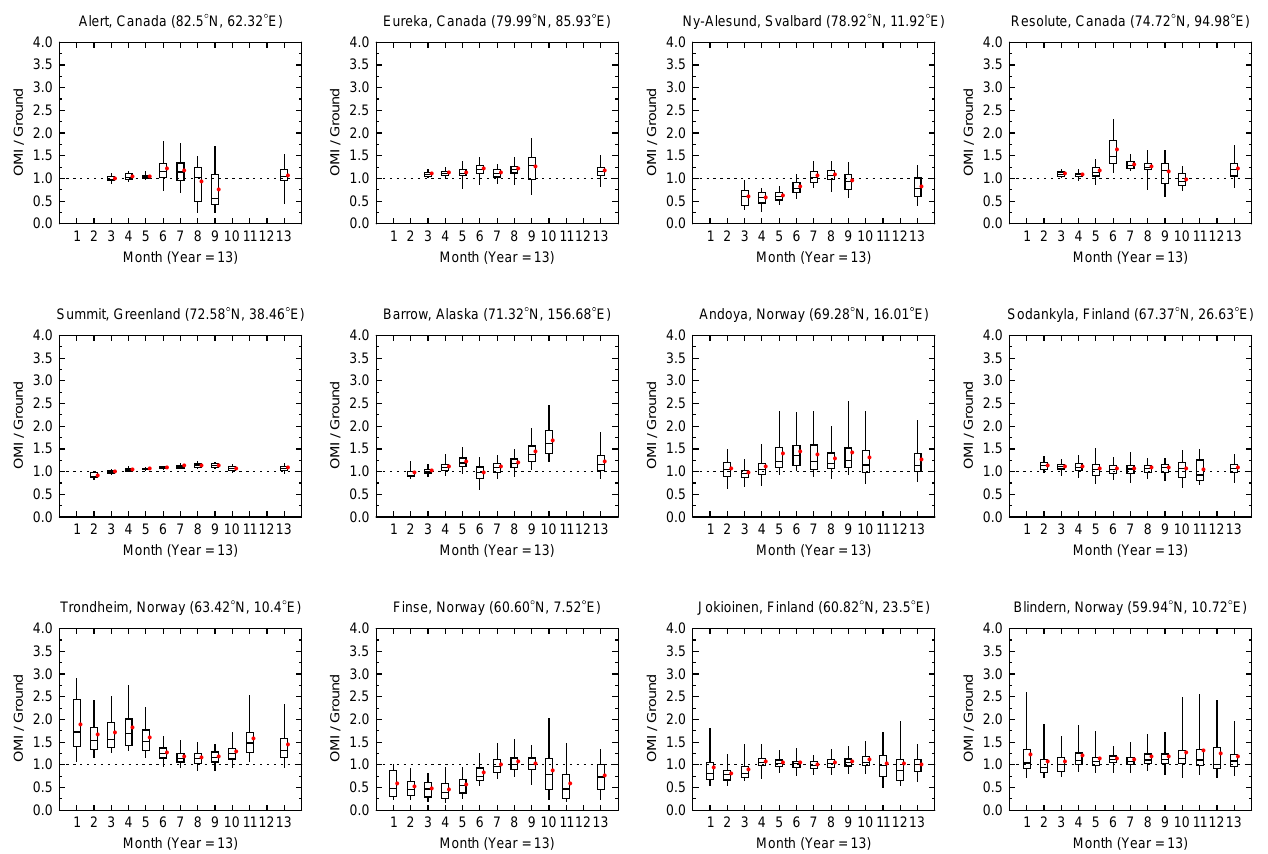
Figure 4. Ratio of the erythemal daily dose (DP 4) measured by OMI and ground stations for each site. The box-whisker plots indicate for each month the 5th and 95th percentiles (whisker), the interquartile range (box), median (line), and average (red dot). Statistics based on annual data are indicated as the 13th month. Match-up data were filtered for SZA < 84 ◦ and Dis <